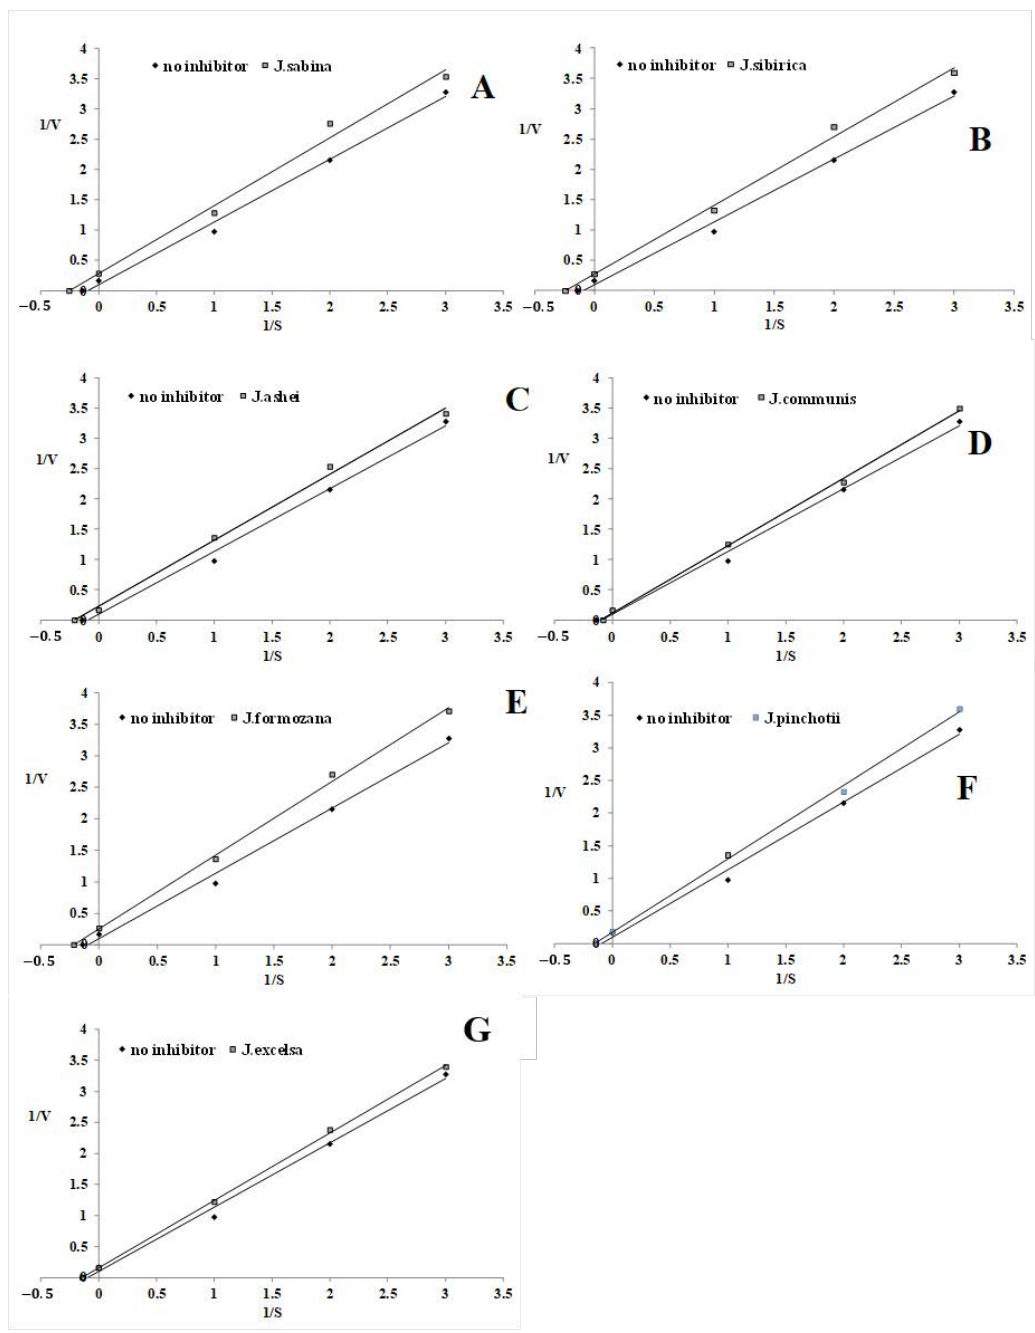
Figure 3. Mode of lipoxygenase (LOX) inhibition by extracts from leaves of previously selected juniper representatives. ( A ) J. sabina , ( B ) J. sibirica , ( C ) J.ashei , ( D ) J. communis , ( E ) J. formozana , ( F ) J. pinchotii , ( G ) J.excelsa . V—rate of enzymatic reaction expressed as the absorbance unit (see methodology), S—the substrate concentration (see